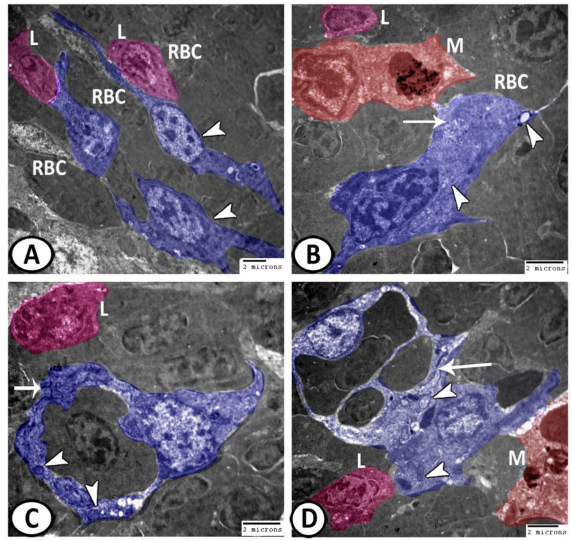
Figure 9. Digital colored TEM of the epithelial reticular cells in the spleen. ( A ) The epithelial reticular cells (blue, arrowheads) extended their processes between the lymphocytes (L, pink) and erythrocytes (RBC). ( B ) They showed a connection with macrophages (M, red) and their cytoplasm possessed numerous ribosomes (arrow) and electron-lucent vesicles (white arrowheads). ( C , D ) They were characterized by the presence of mitochondria (arrowheads) and rER (arrows). Note the presence of macrophages (M, red) and lymphocytes (L, pink).